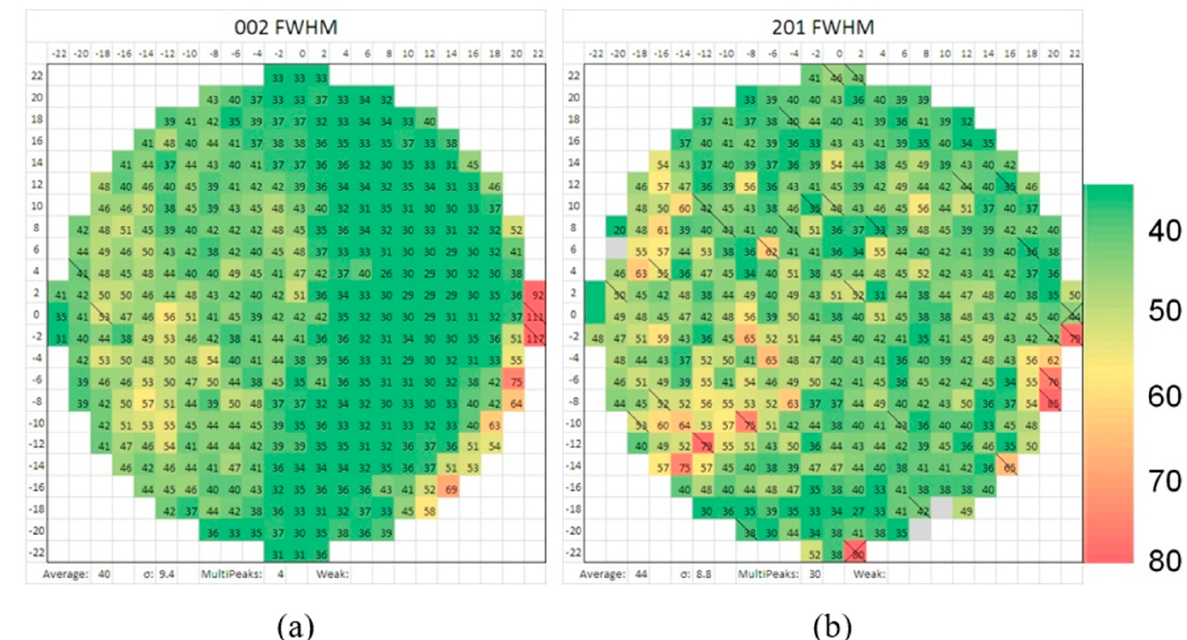
Figure 6. X-ray FWHM maps of a 2 ″ GaN substrate produced by HVPE. The numbers on each axis present position from the center in mm, and the numbers in the boxes and next to the scale bar are the FWHM value in arcsec. Boxes with a single diagonal line indicate a double peak in the rocking curve and boxes with double diagonal lines indicate a triple peak in the rocking curve. ( a ) FWHM of 002 rocking curves; ( b ) FWHM of 201 rocking